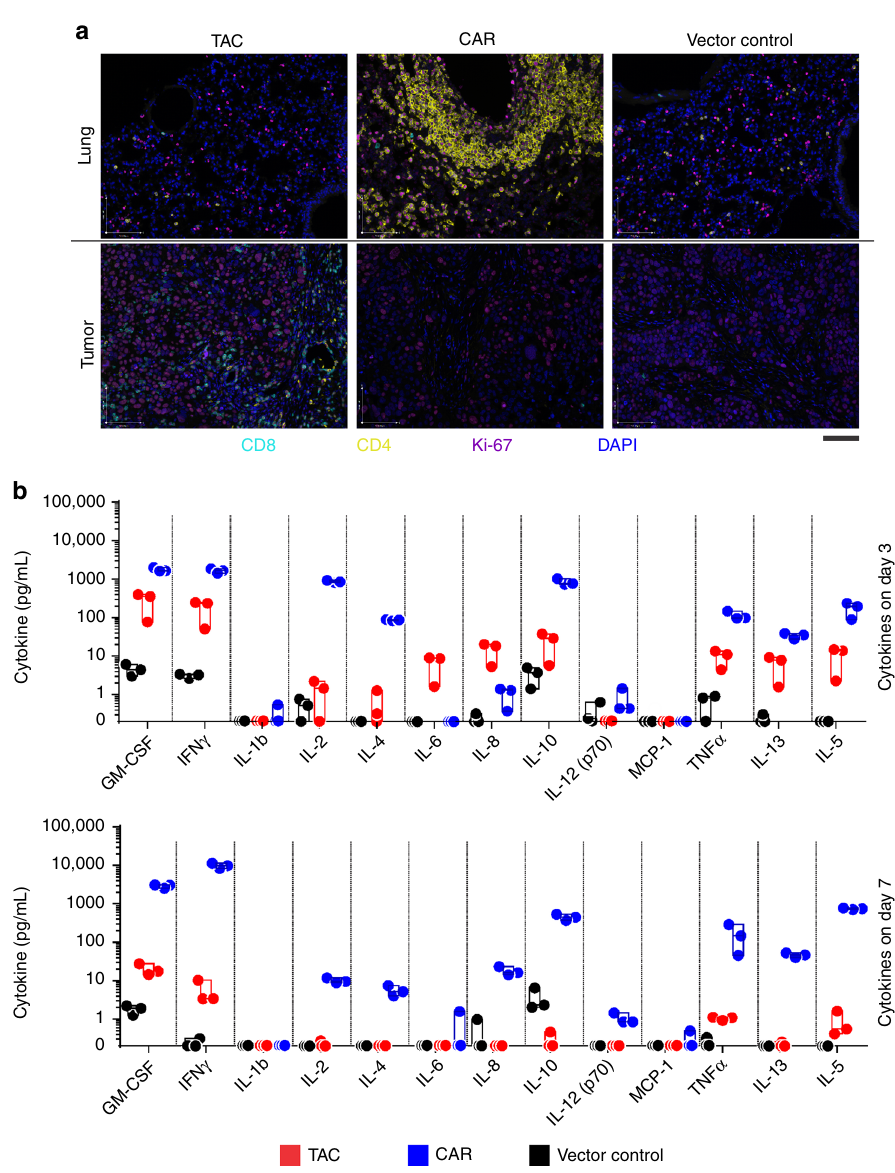
Fig. 6 Engineered T cell distribution and cytokine release in vivo. OVCAR-3 tumor-bearing mice were treated with 6.0 × 10 6 anti-HER2 28 ζ CAR- or HER2- TAC-T cells, or a matched total number of vector control cells. Mice are sacri fi ced at 1, 3, 5, and 7 days post-ACT1 for multiplex serum cytokine analysis or perfusion and fi xation of tissues for subsequent histology. a Multicolor IHC is performed on tumor and lung tissue 7 days post-ACT1. Tissues are stained for CD8 (cyan), CD4 (yellow), DNA (blue) and a proliferation marker (Ki-67, purple). Data are representative of 3 mice. Scale bar indicates 100 μ m. b Multiplex analysis of human cytokines in mouse serum on day 3 and 7. Measurements that fall below 0.2 pg/mL are below the calibration range and are therefore de fi ned as 0. 0 values are depicted on the graph ’ s x axis. Statistical analysis is provided in Supplementary Table 1, analysis was performed using multiple t -test. Individual data points are shown, bars indicate standard deviation and center bars indicate the